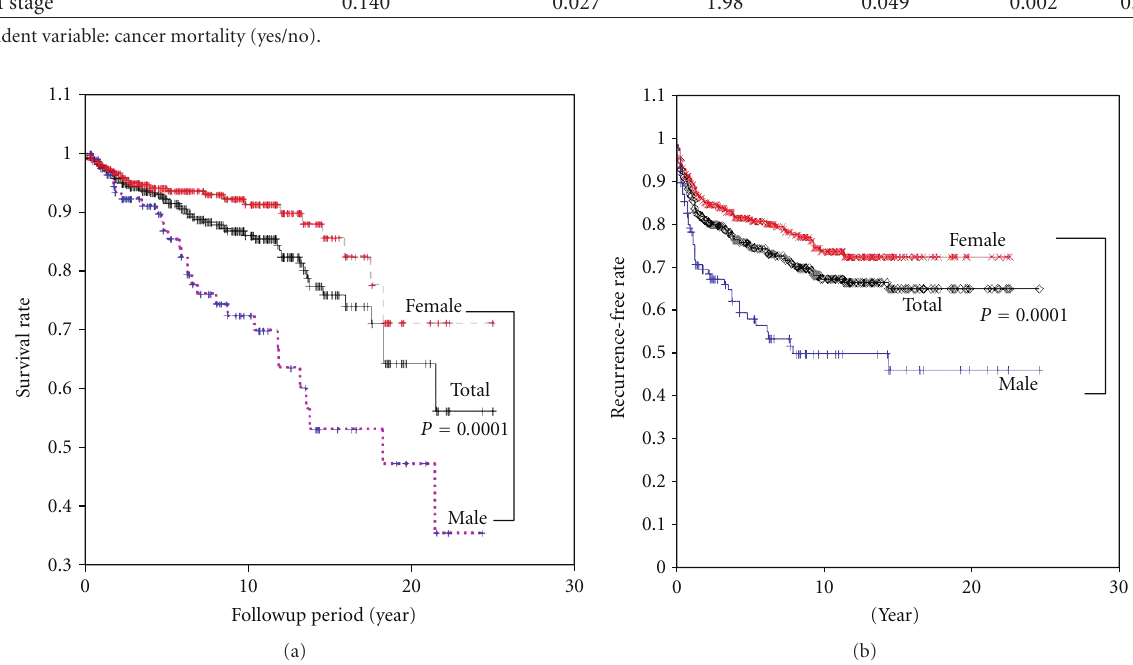
Figure 1: Thyroid cancer mortality (a) and recurrence-free survival (b) curves of the male, female, and total